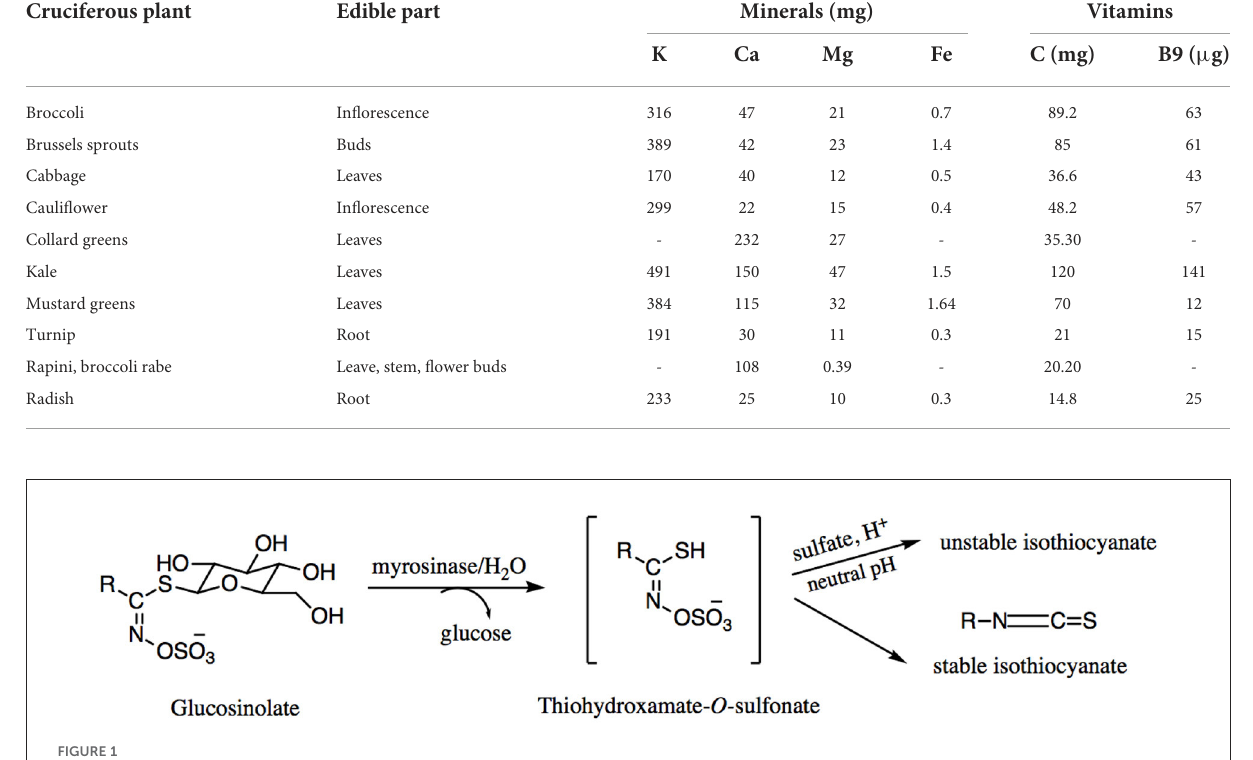
FIGURE1 Enzymatic hydrolysis pathways of glucosinolate.